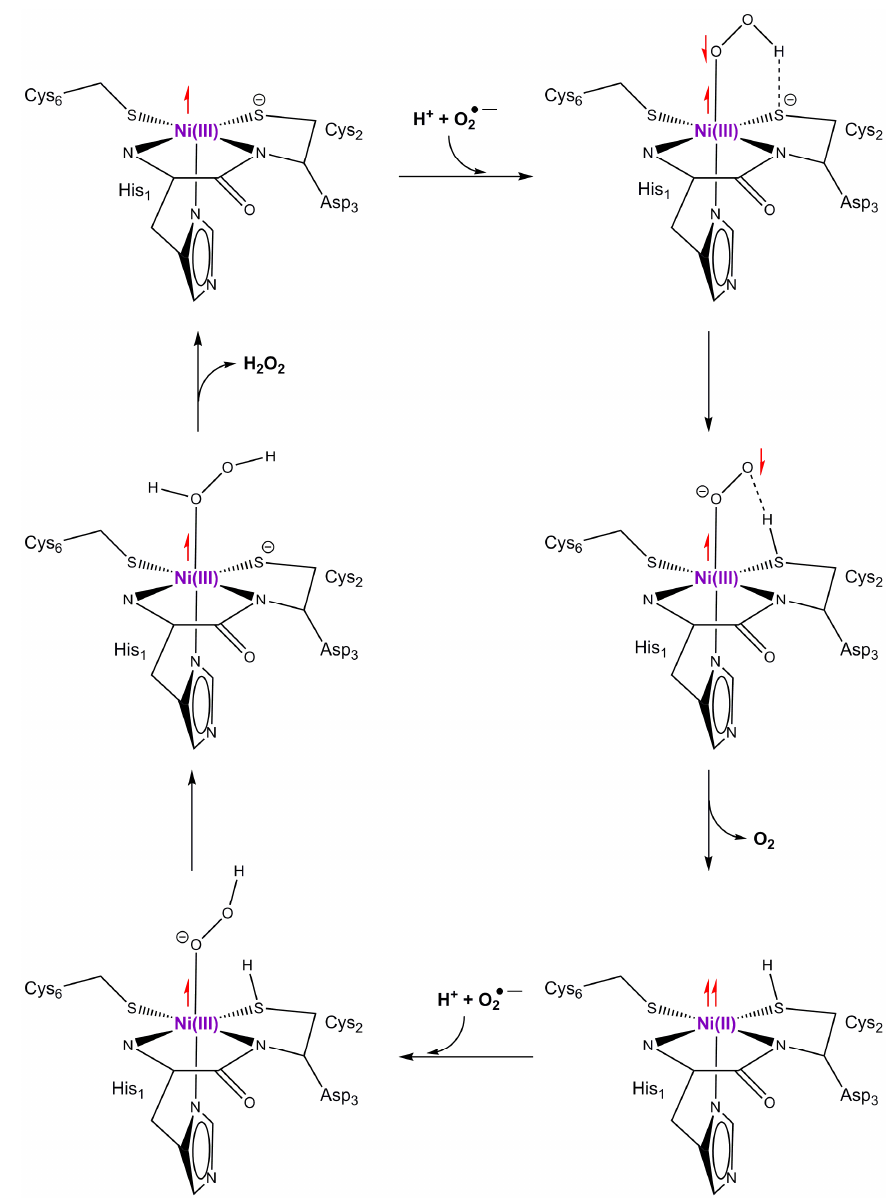
Figure 11. Reaction mechanism for superoxide dismutase (Ni-SOD) suggested by Pelmenschikov et al. Adapted from [134], Copyright © 2006, American Chemical Society.